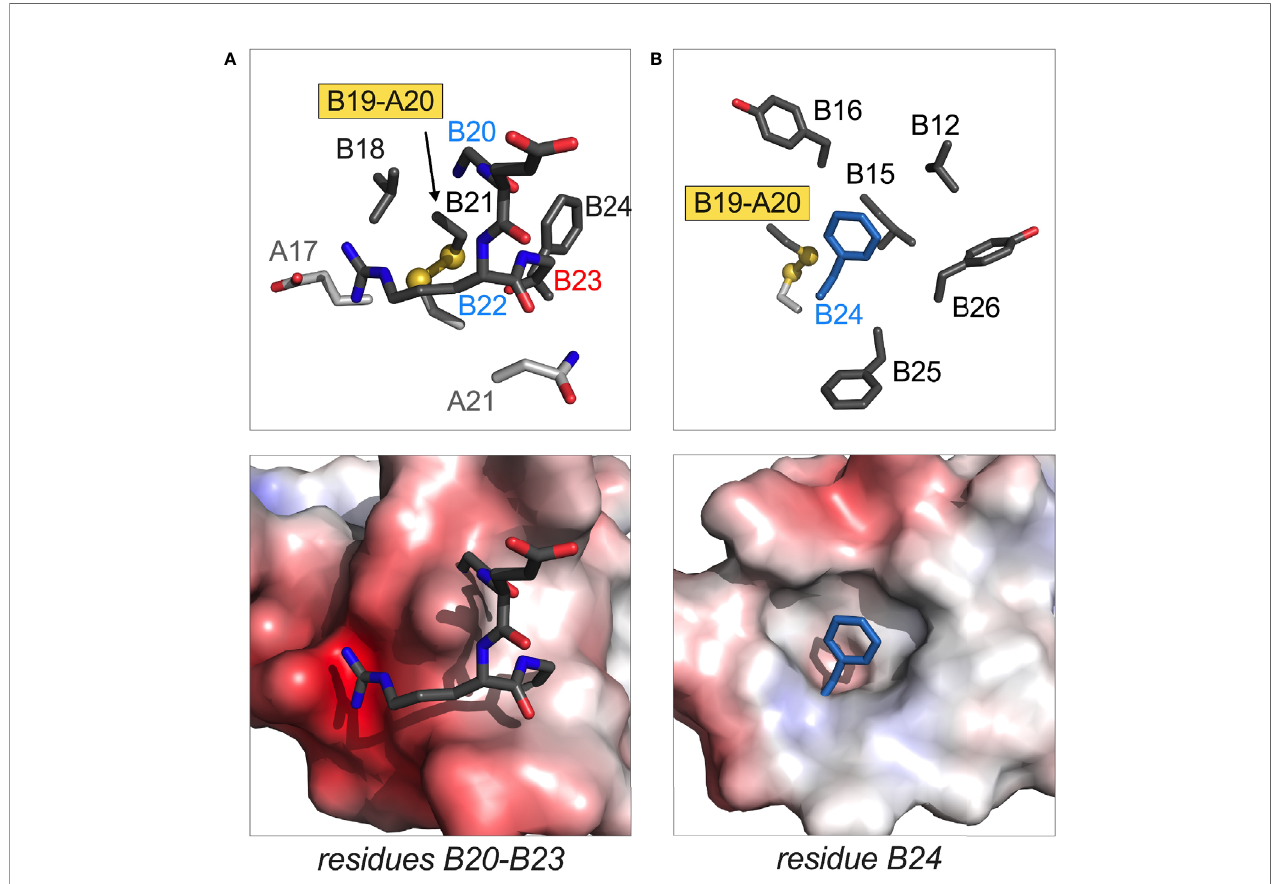
FIGURE 6 | Structural sites of MODY mutations. (A) Residues B20 and B22 in B-chain B20-B23 b -turn; (B) residue B24 anchoring this b -turn and adjoining B24- B28 b -strand. In each pair of images, stick models are in upper panel and electrostatic surfaces in lower panel. The latter highlights the groove or cavity occupied by the designated structural element; blue and red surfaces are coded by positive or negative electrostatic potential. In stick models main-chain atoms in A- or B main chains are shown in light or dark gray, respectively. Disul fi de bridges are shown as balls and sticks with sulfur atoms in gold (one-third Van der Waals radii). The side chain of Phe B24 in (B) is shown as dark blue stick (not related to electrostatic potential). Coordinates were obtained from PDB entry 4INS